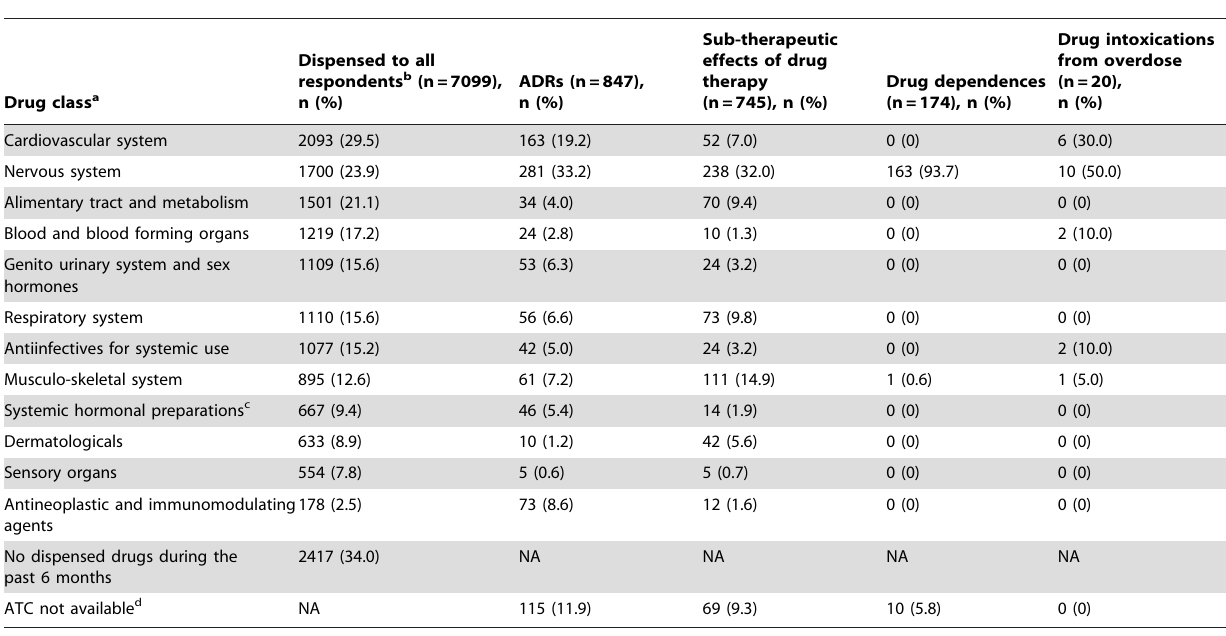
Table 4. Drug classes a associated to self-reported adverse drug events (ADEs), ordered according to the most commonly dispensed drugs to all